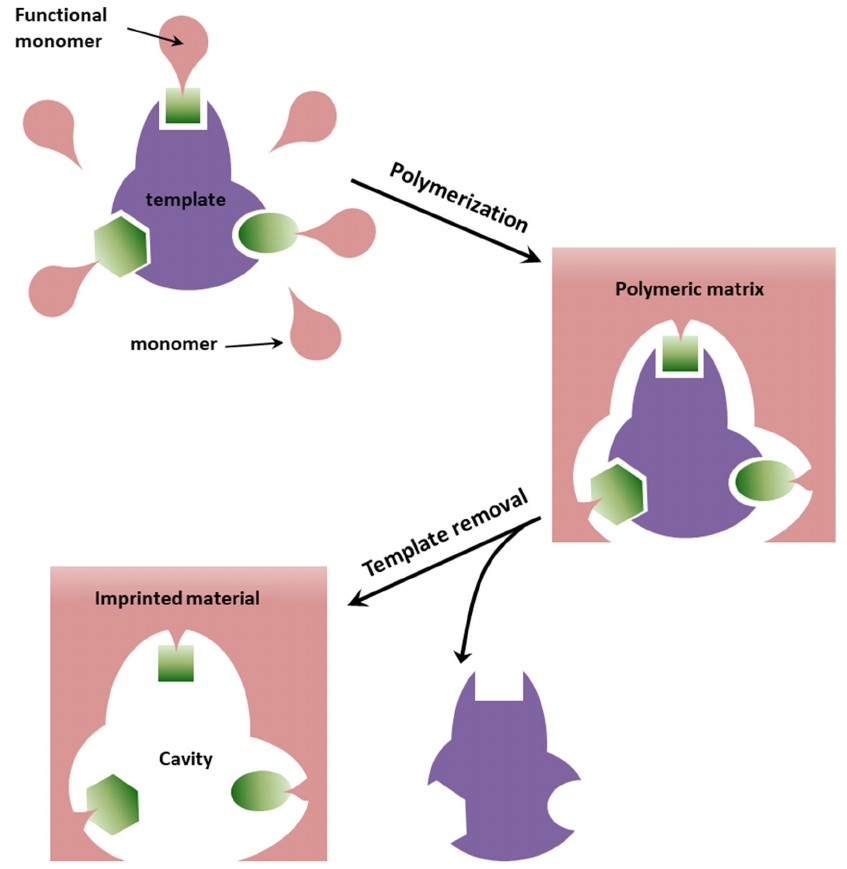
Figure 2. The molecular imprinting process.